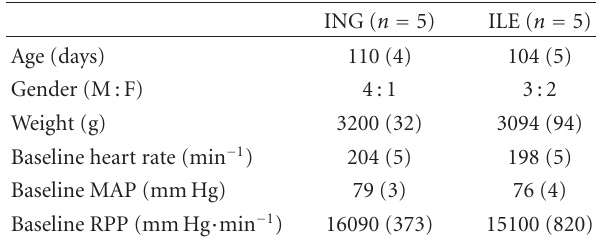
Table 1: Animal characteristics and baseline parameters according to group.